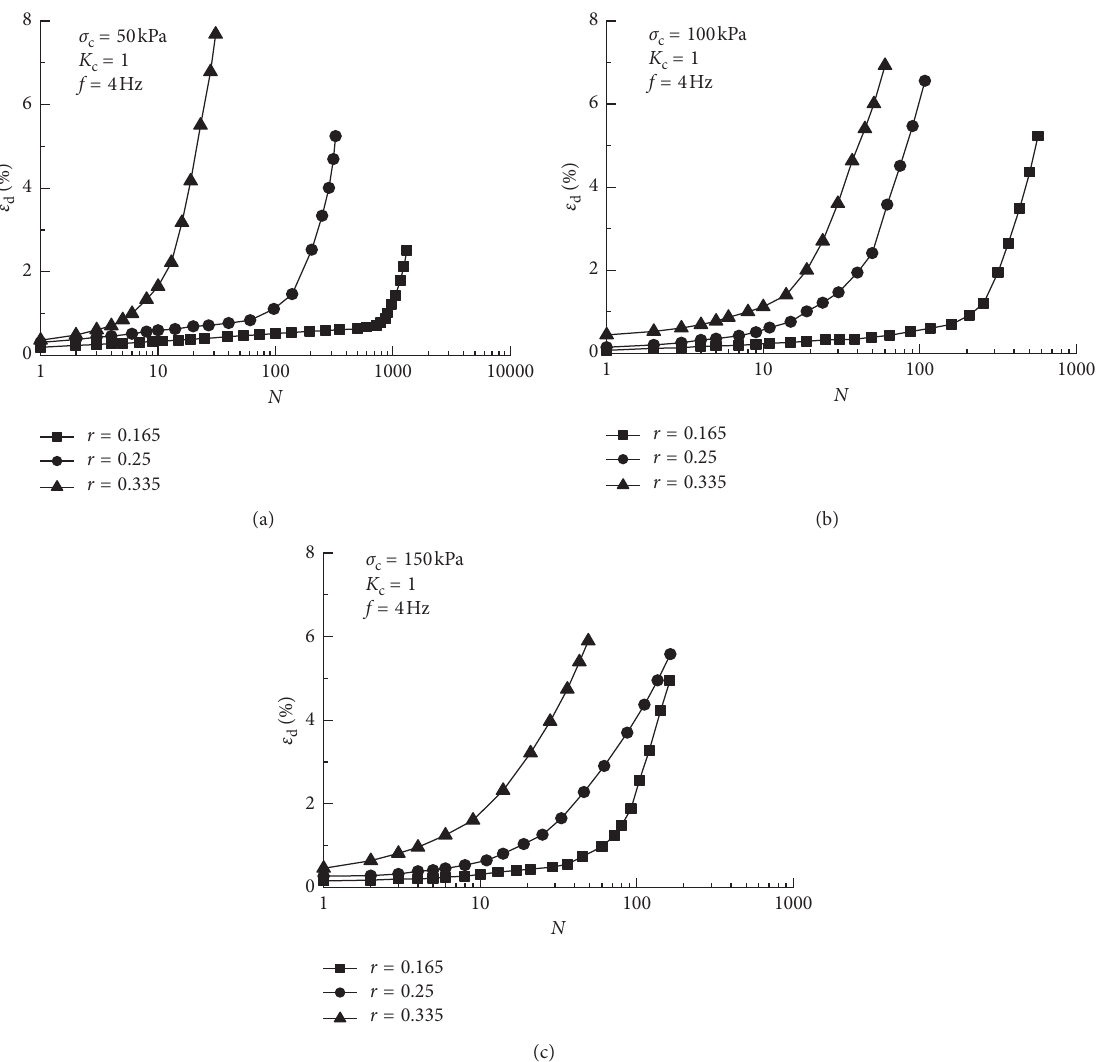
Figure 7: Relationship curves between ε